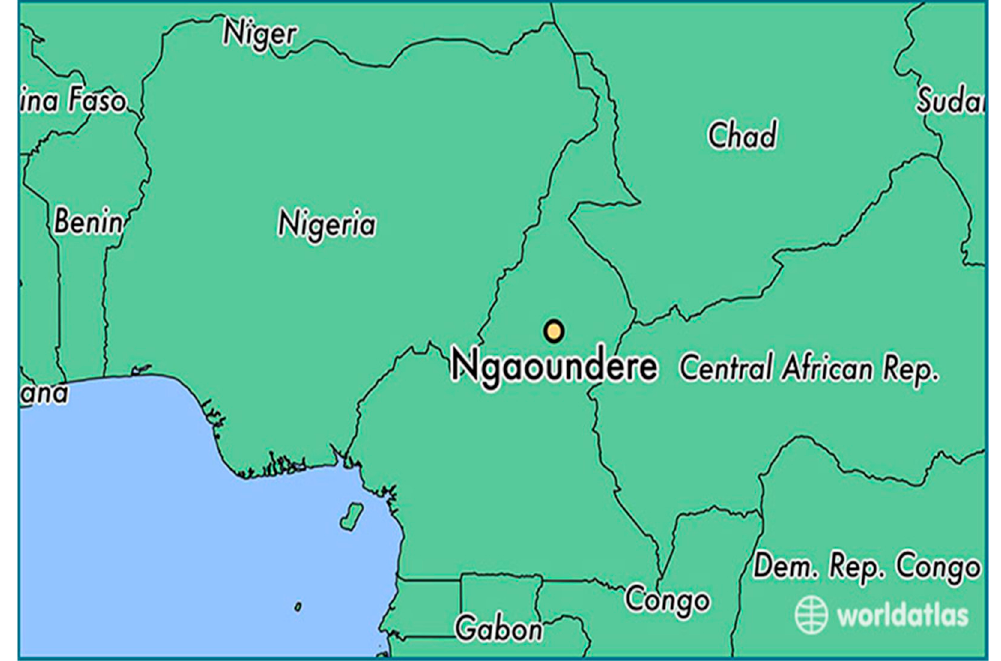
Figure 1. Location of Ngaoundéré on the geographical map [32].